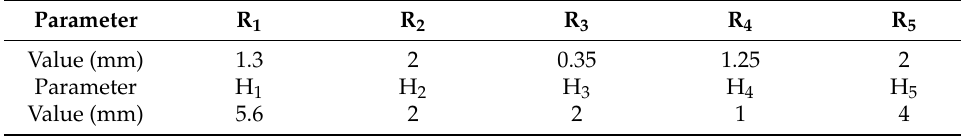
Table 1. The Specific Value of Geometric